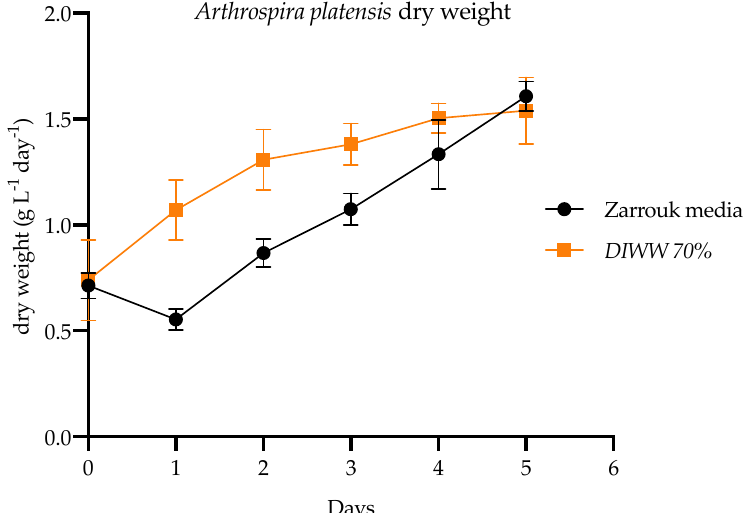
Days Figure 2. Growth, measured as the chlorophyll ‐ a concentration of Arthrospira platensis cultivated in Figure 2. Growth, measured as the chlorophyll ‐ a concentration of Arthrospira platensis cultivated in Figure 2. Growth, measured as the chlorophyll ‐ a concentration of Arthrospira platensis cultivated in Figure 2. Growth, measured as the chlorophyll ‐ a concentration of Arthrospira platensis cultivated in Figure 2. Growth, measured as the chlorophyll- a concentration of Arthrospira platensis cultivated in Figure 2. Growth, measured as the chlorophyll ‐ a concentration of Arthrospira platensis cultivated in Figure 2. Growth, measured as the chlorophyll ‐ a concentration of Arthrospira platensis cultivated in Zarrouk media ( ), and wastewater from the dairy industry ( ). Values are average ± SD ( n Zarrouk media ( ), and wastewater from the dairy industry ( ). Values are average ± SD ( n Zarrouk media ( ), and wastewater from the dairy industry ( ). Values are average ± SD ( n Zarrouk media ( ), and wastewater from the dairy industry ( ). Values are average ± SD ( n Zarrouk media ( ), and wastewater from the dairy industry ( ). Values are average ± SD ( n Zarrouk media ( ), and wastewater from the dairy industry ( ). Values are average ± SD ( n Zarrouk media ( ). Values are average ± SD ( n = 3). = 3). = 3). = 3). = 3). = 3). = 3). The productivity values of the cultures maintained in DIWW (1.26 ± 0.31 g L − 1 d − 1 ) not present significant differences concerning the control (Zarrouk medium) (1.20 ± 0.38 g L − 1 d − 1 ) (Tukey P test ≤ P test ≤ 0.05) (Figure 3). 0.05) (Figure 3).